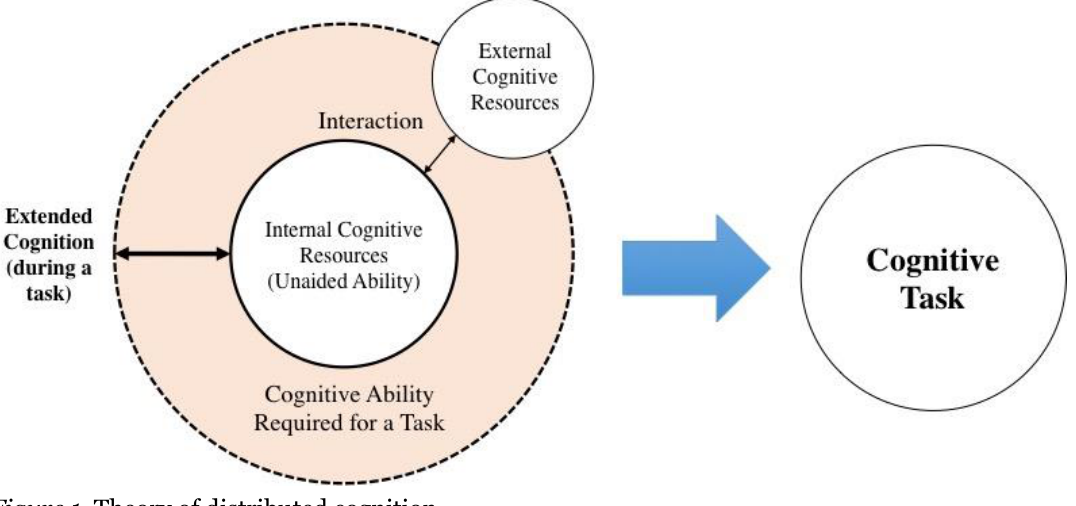
Figure 1. Theory of distributed